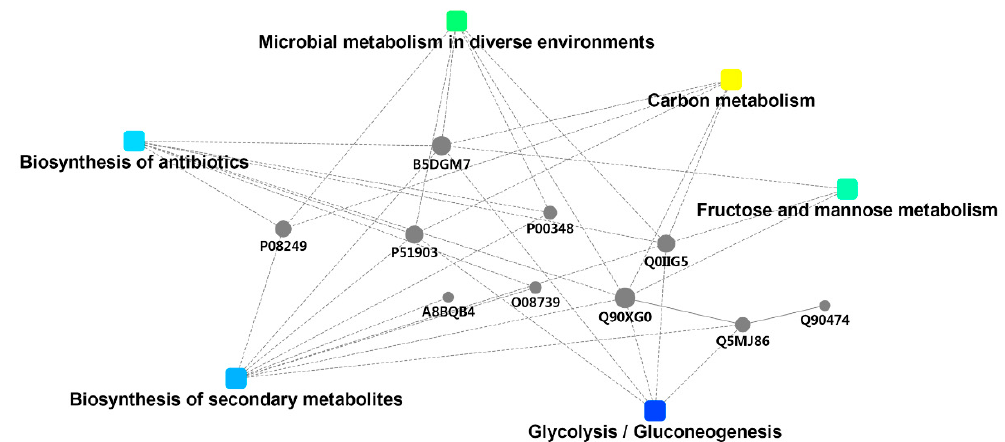
Figure 7. Interaction network analysis of differentially significant expressed proteins (DSEPs) for vs. Day 6 vs. Day Day 0 vs. Day 6 vs. Day 12.